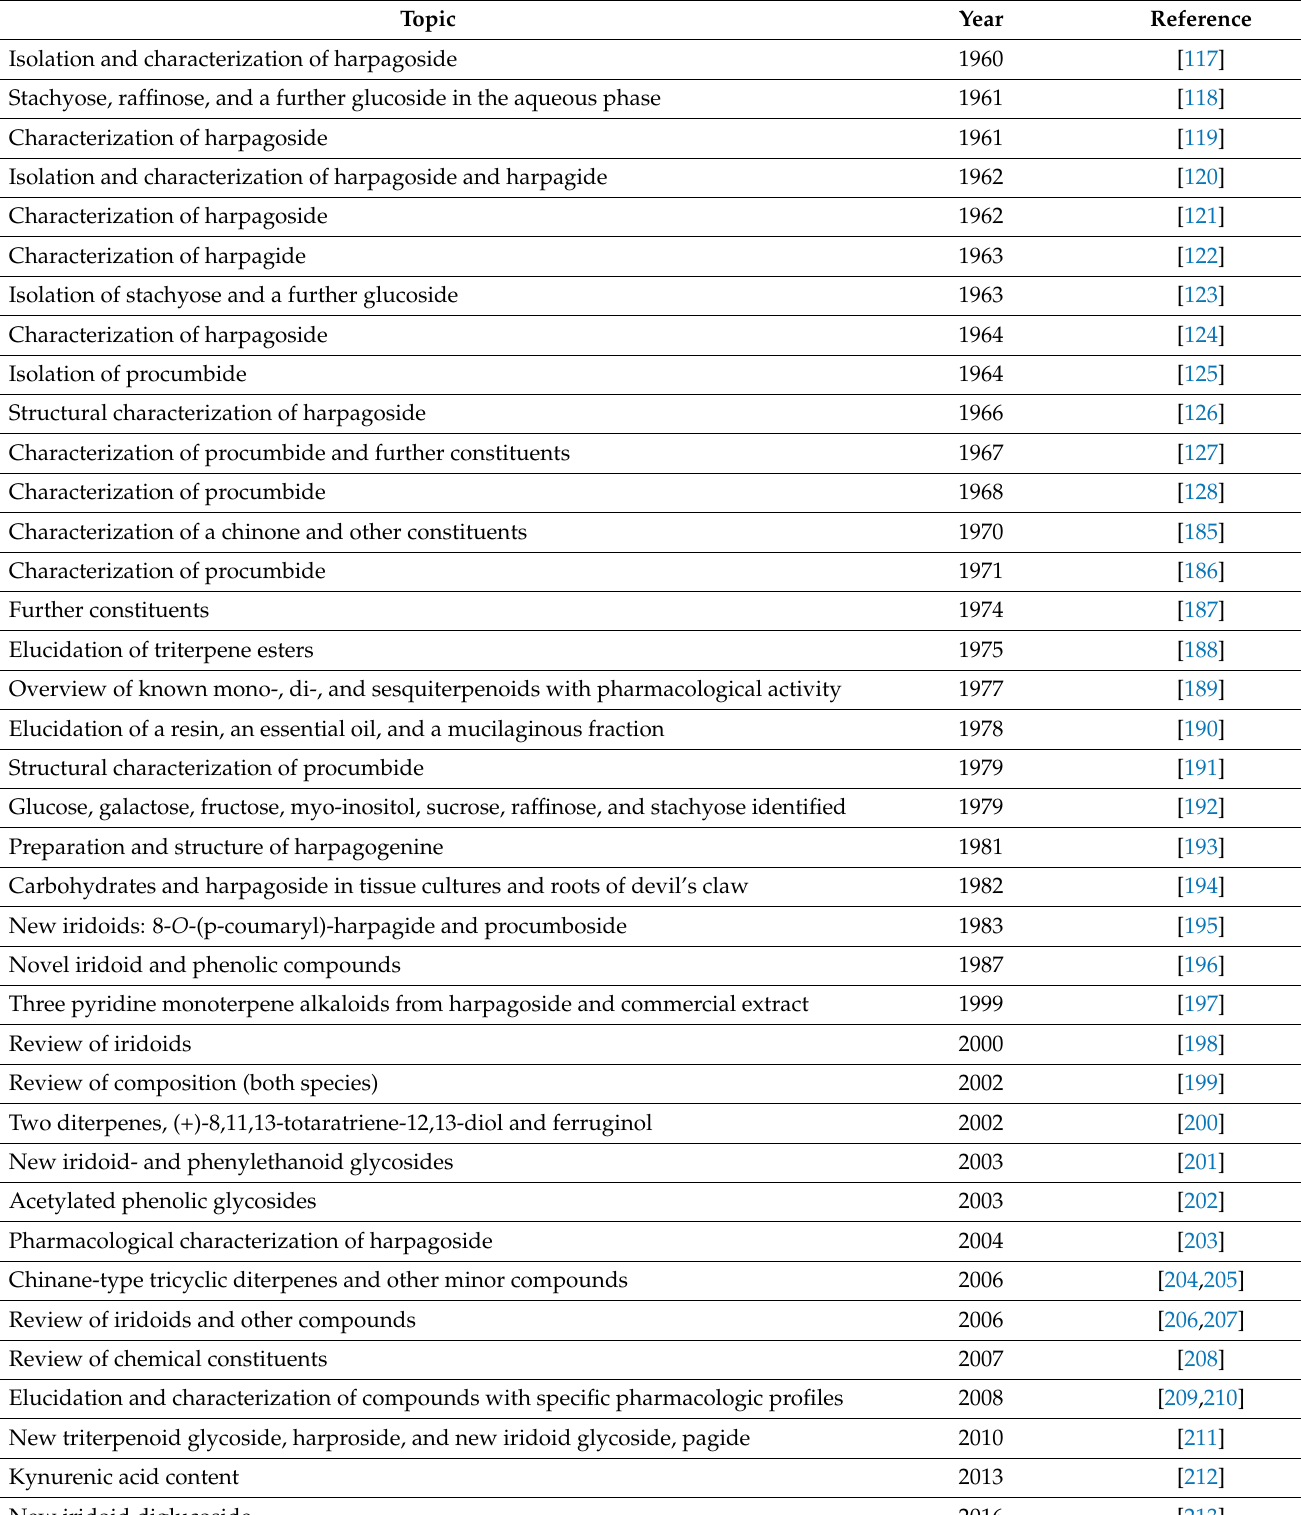
Table 2. Elucidation of the biochemical composition of devil’s claw